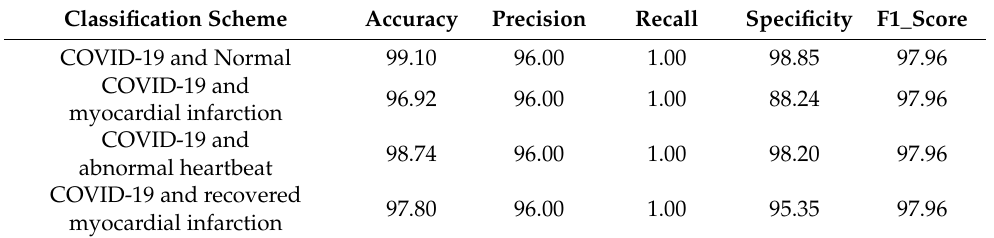
Table 8. Evaluation on ECG Images dataset of Cardiac and COVID-19 Patients binary